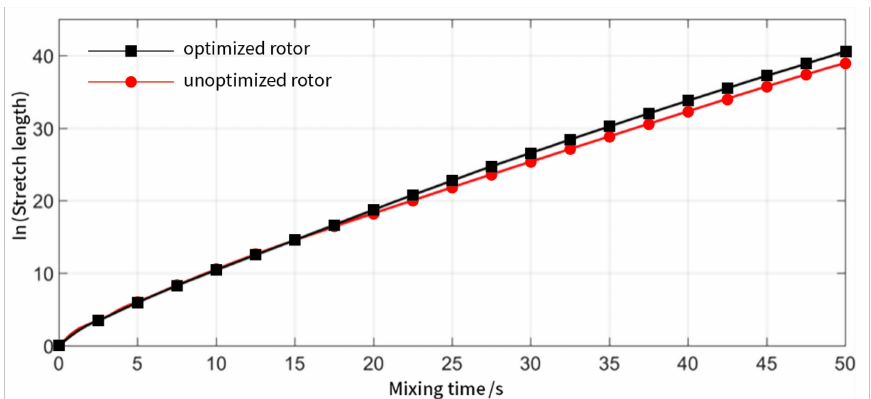
Figure 11. Mean logarithmic stretch length of the optimized rotor (black) and rotor before optimization (red) as a function of